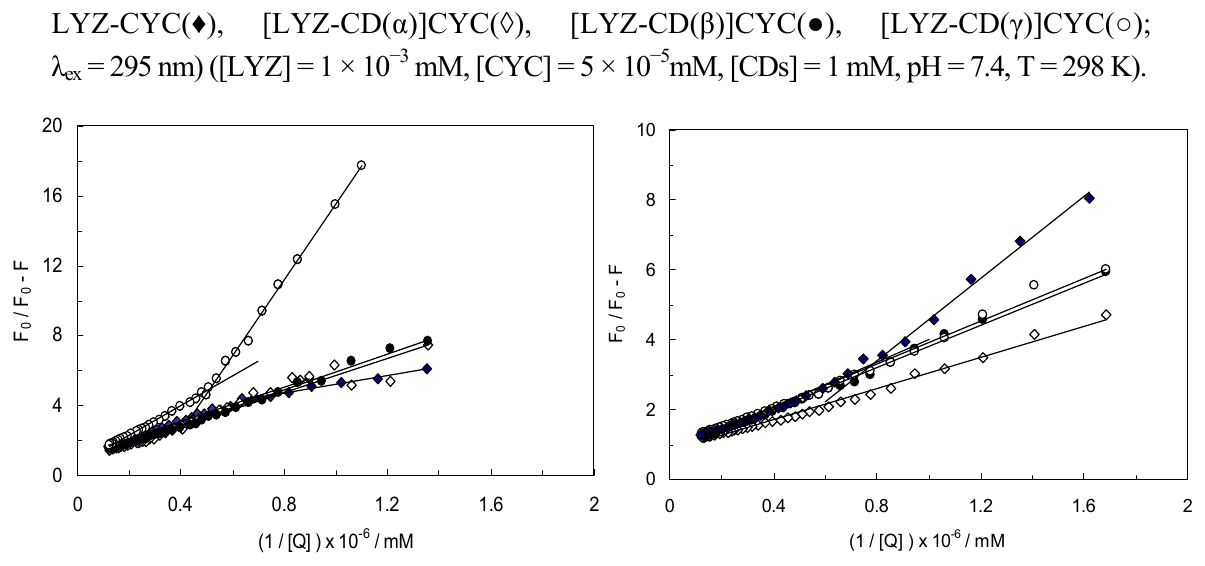
Figure 5. Modified Stern-Volmer plots for the fluorescence quenching of LYZ-CYC( ♦